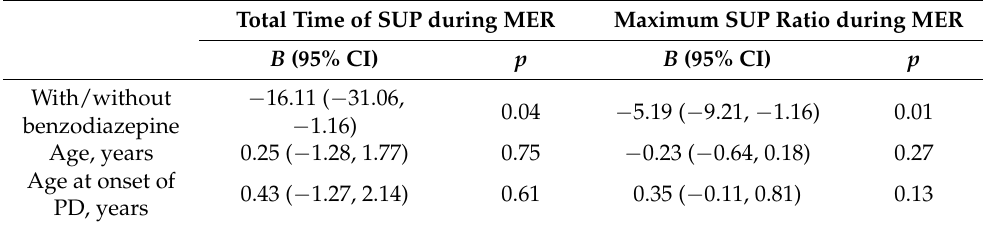
Table 4. Results of linear regression